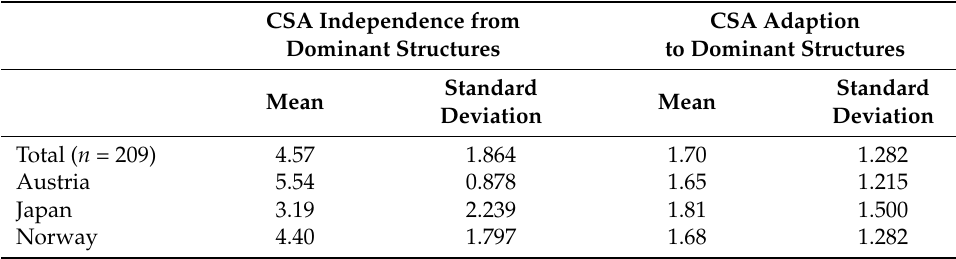
Table 6. Institutional proximity to dominant food system structures ( n = 209). CSA Independence from Dominant Structures